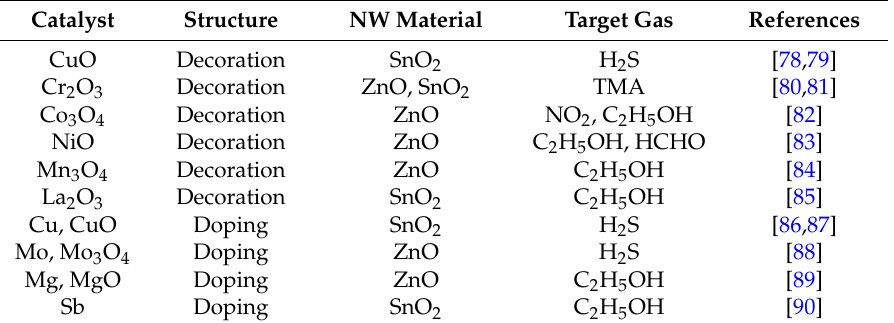
Table 2. Metal-oxide-catalyst-doped and -decorated NWs and their target gases [78–90].